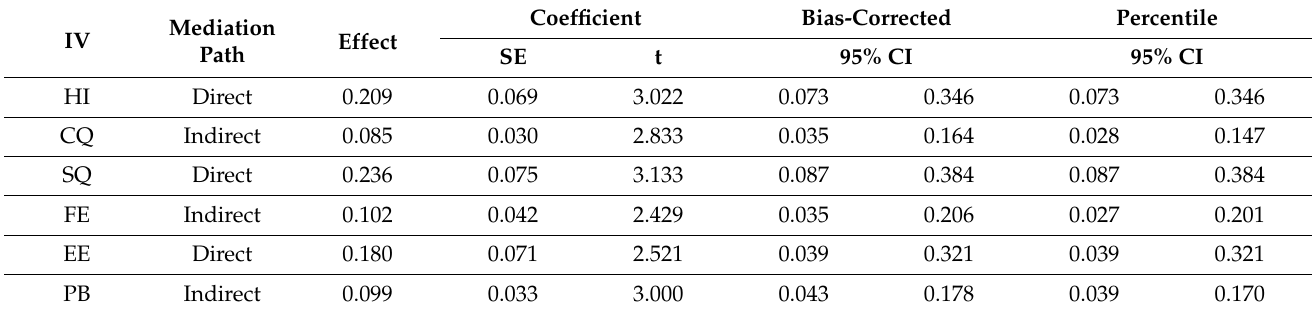
Table 8. The mediating roles of emotional experiences in the relationships between system character- istics and citizenship